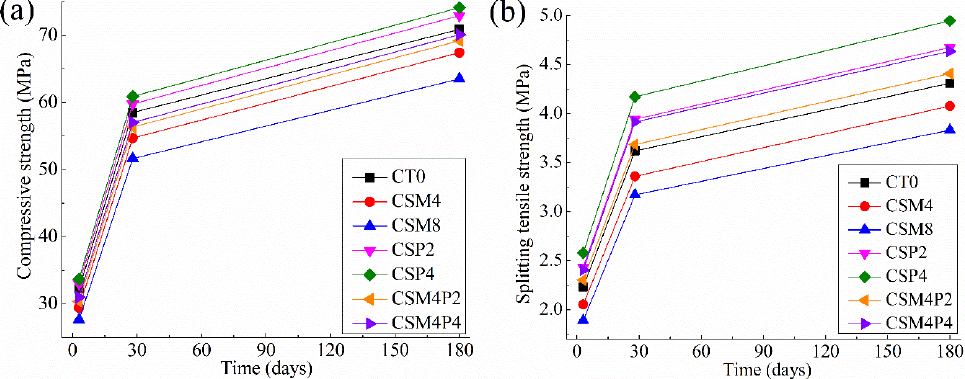
Figure 4. ( a ) Compressive strength and ( b ) splitting tensile strength of hydraulic concretes added with MgO and/or PVA fiber.